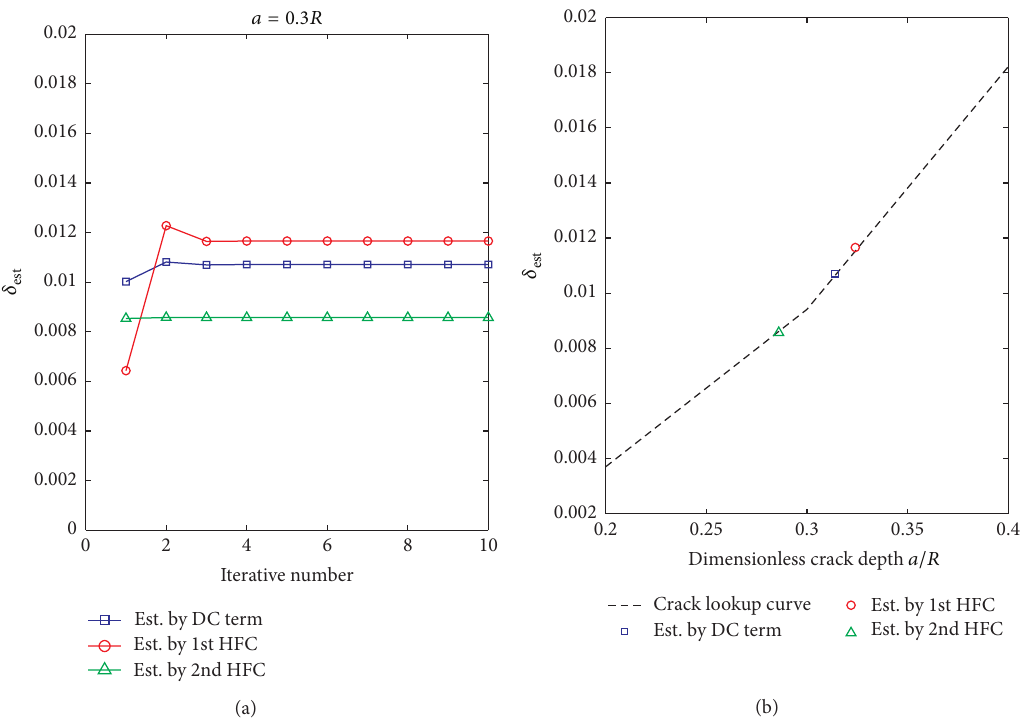
Figure 9: Damage parameters estimation for crack 𝑎 = 0.3𝑅 : (a) damage estimates iteration; (b) correlation between damage estimates and crack